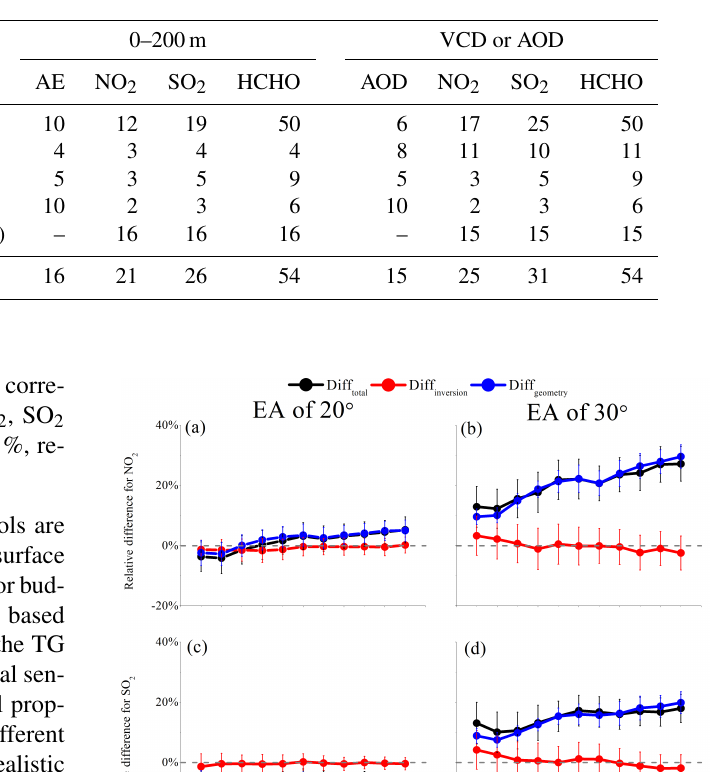
Table 4. Averaged error budget (in %) of the retrieved TG VCDs and AOD, and near-surface (0–200m) TG VMRs and AE. The total uncertainty is calculated by adding the different error terms in Gaussian error propagation.